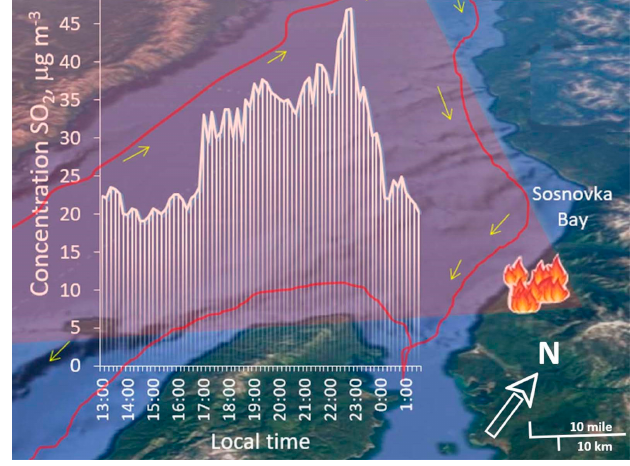
Figure 8. Temporal variation of SO 2 near Sosnovka Bay (29 July 2019).